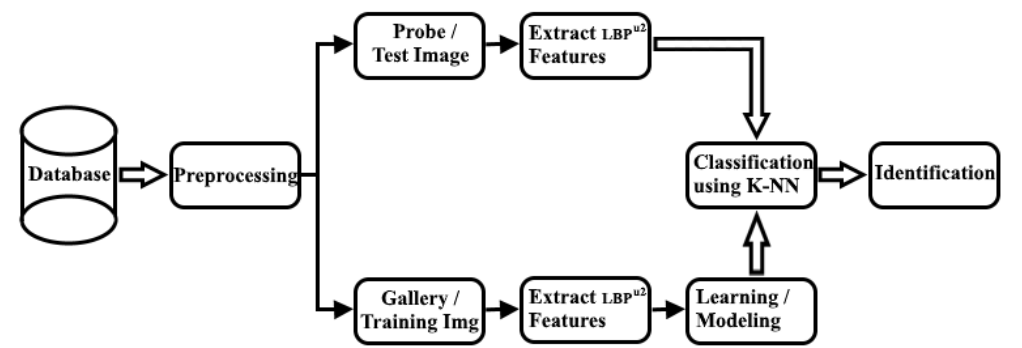
Figure 3. Diagram of the process. K-NN: k-nearest